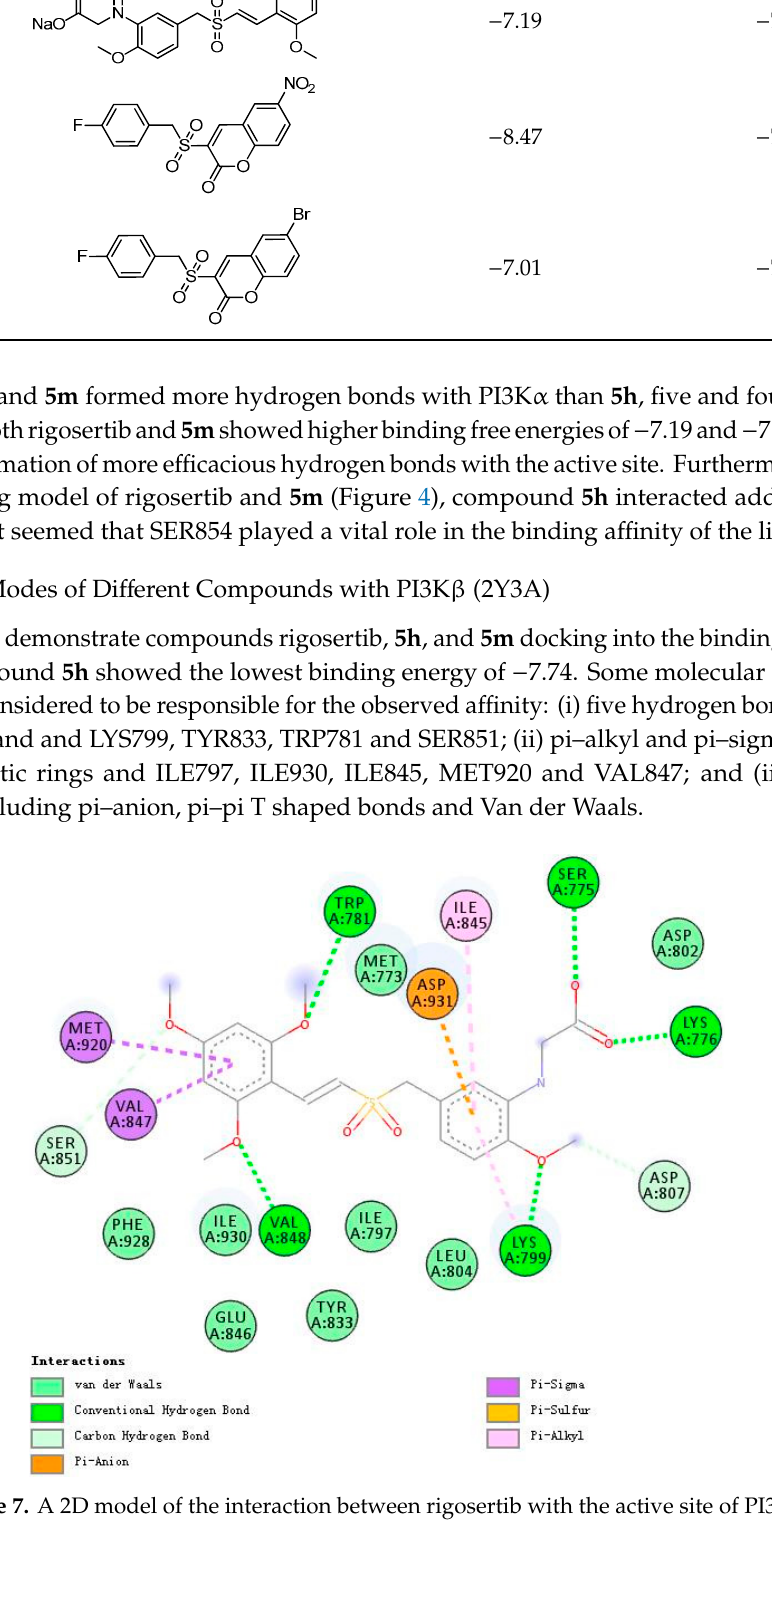
Table 4. Binding energies of compounds 5h and 5m with the PI3K α and PI3K β enzymes. Compound